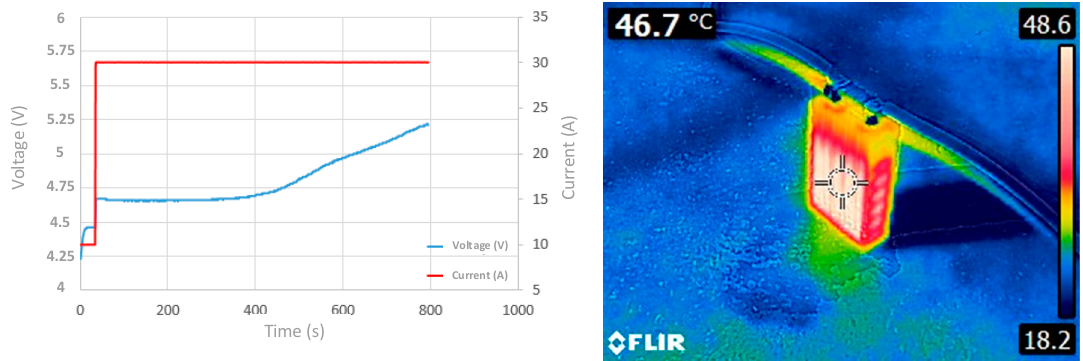
Figure 3. Waveforms of charging current and voltage during overcharging concerning 6.25 V of charging voltage level.